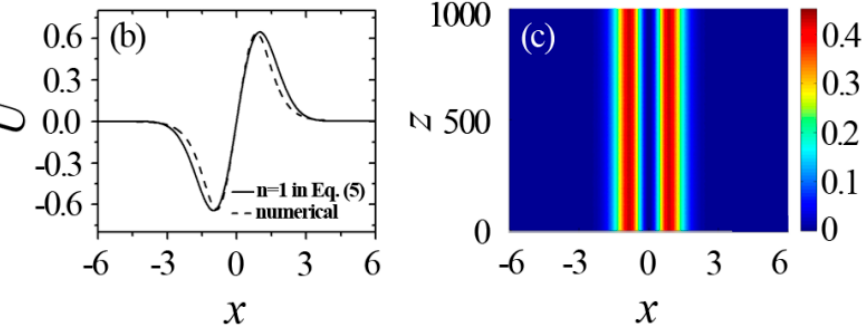
Figure 5. An example of a stable dipole-mode soliton produced by Equation (1) with Lévy index α = 1, parabolic trapping potential (32) with Ω 2 = 1, i.e., V ( x ) = 0.5 x 2 , and nonlinearity strength g = 0.5. The propagation constant of this state is − µ = 1.16. The stationary profiles of the soliton and its propagation, in terms of the local-power distribution, are displayed in the left and right panels, respectively. The solid line in the left panel represents the analytical fit provided by Equation (33) with n = 1. Adapted with permission from Reference [34]. Copyright 2020 Elsevier. Panel (a) from the original figure is not included here, as it is not